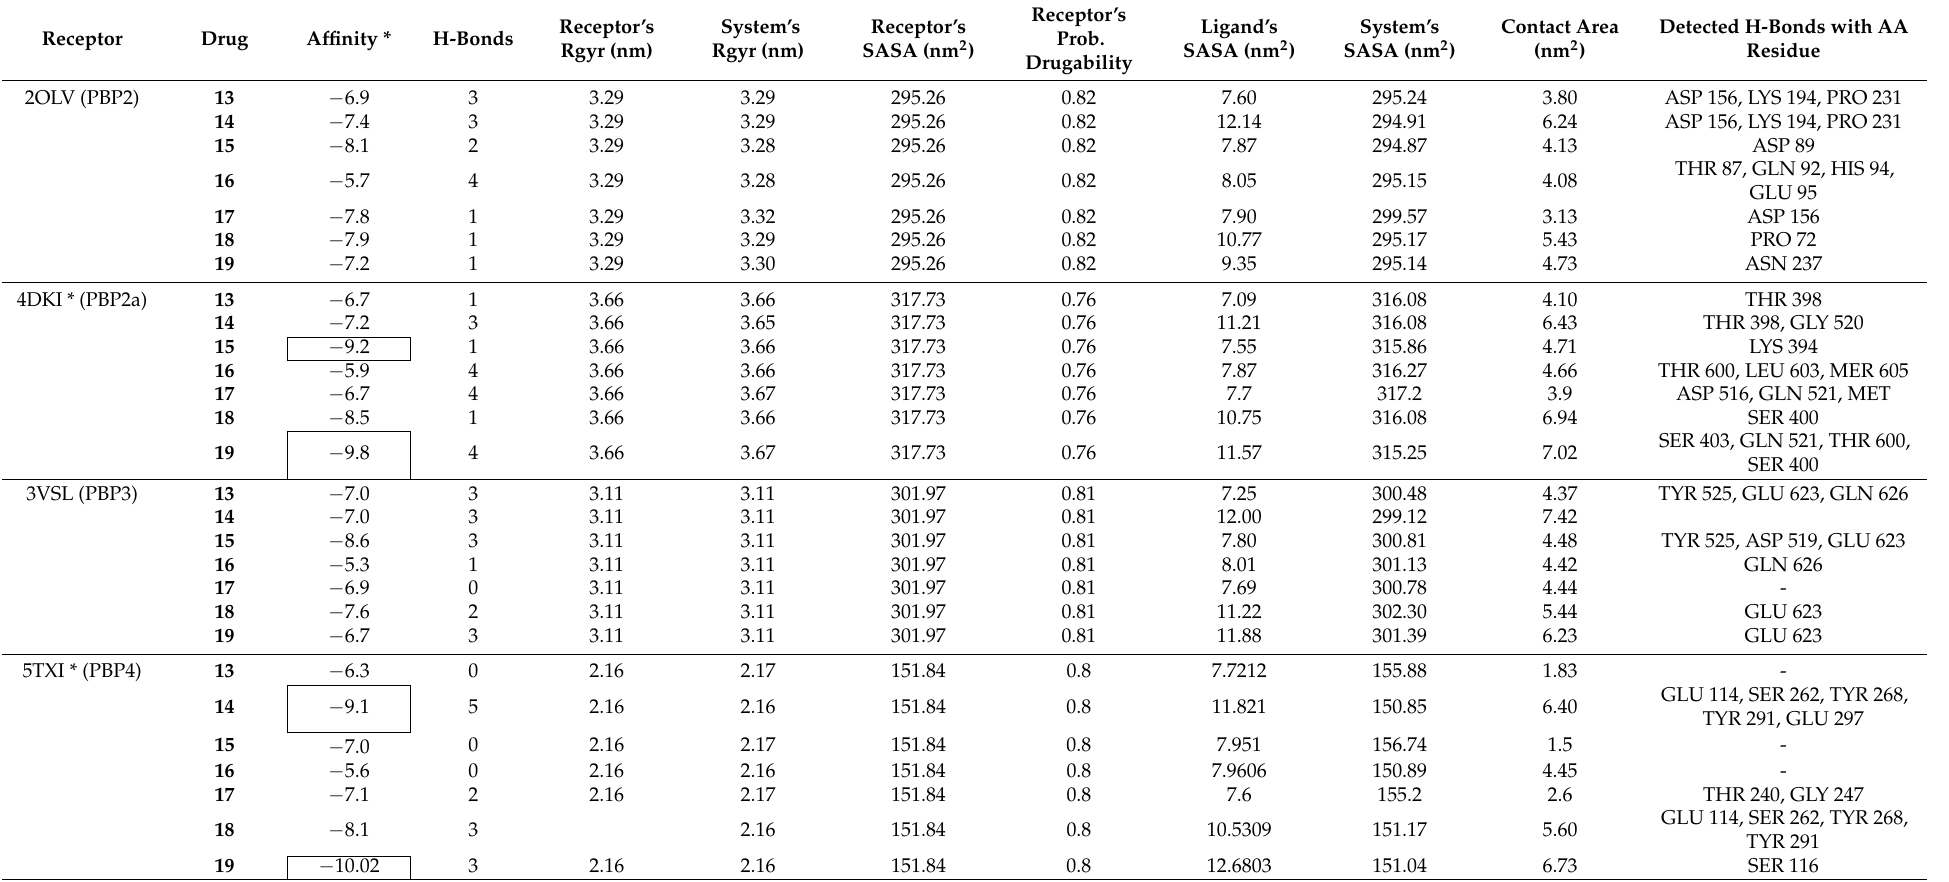
Table 4. Molecular docking scores and related